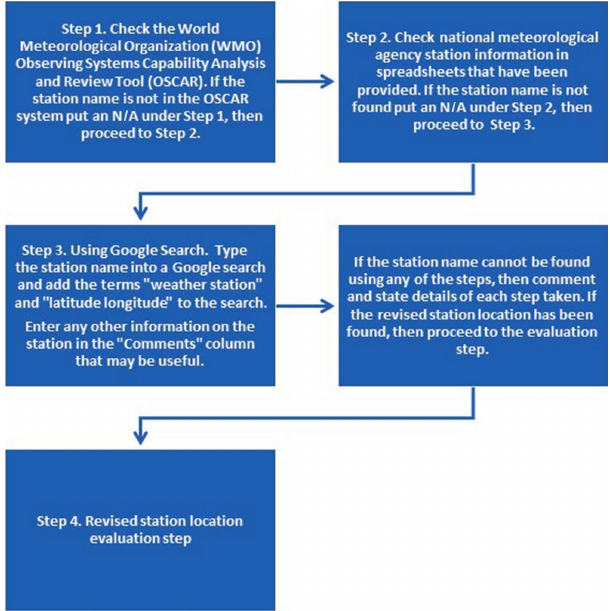
Figure 3. Workflow summary of the guidance and steps required to complete the